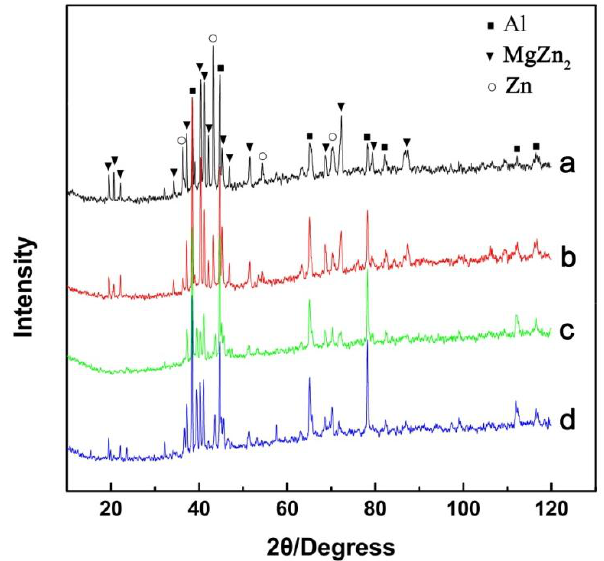
Figure 7. X-ray diffraction patterns of the fusion zone: ( a ; b ; c and d ) the diffraction patterns of the fusion zone using Zn–10Al, Zn–20Al, Zn–30Al and Zn–40Al as the filler metals, respectively.